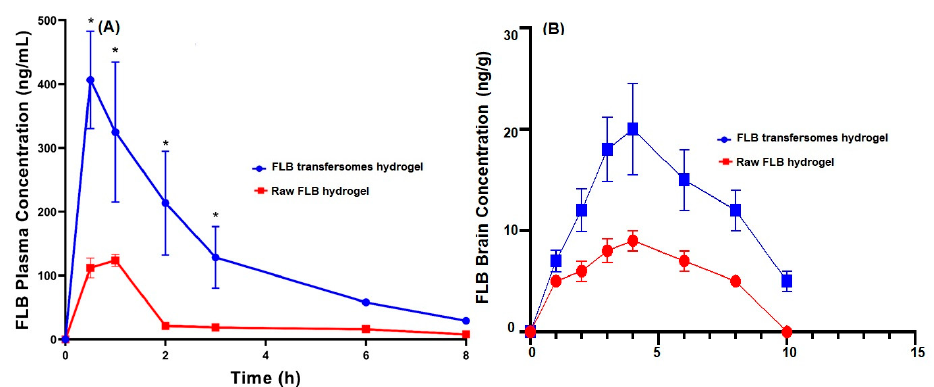
Figure 5. Mean ( A ) plasma concentrations and ( B ) brain concentrations of FLB in rats, plotted against time, after nasal administration of FLB-TRF-loaded intranasal hydrogel compared to control raw FLB hydrogel at a dose of 10 mg/kg. Results presented as mean ± SD, n = 6. * Significant at p < 0.05, Sidak’s